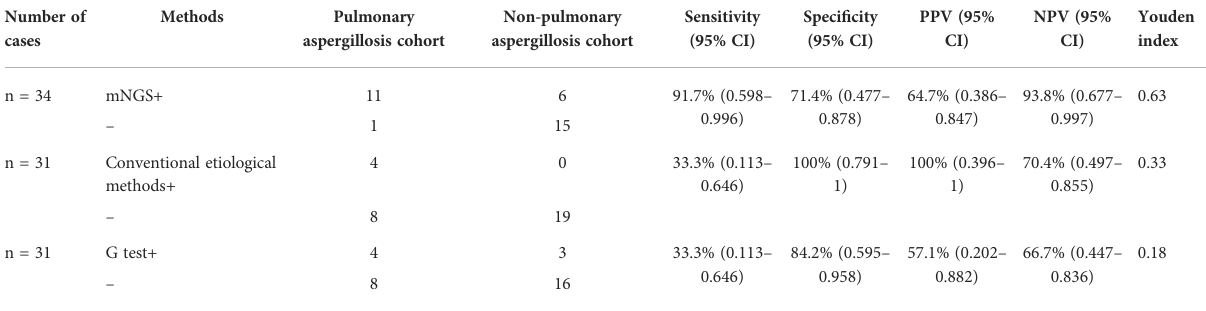
TABLE 2 DiagnosticperformanceofmNGS,conventionaletiologicalmethods,andserum(1,3)- b